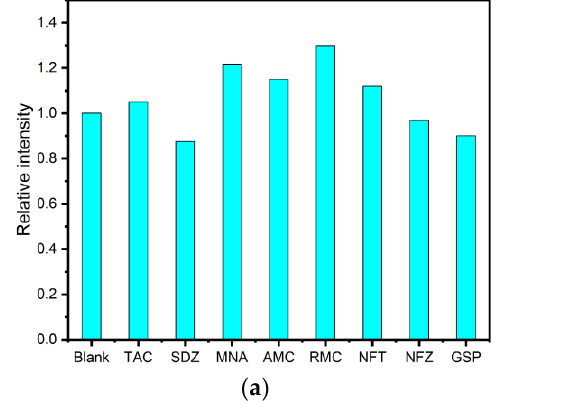
Table 2. Detection limits for other reported gossypol-sensitive MOFs.